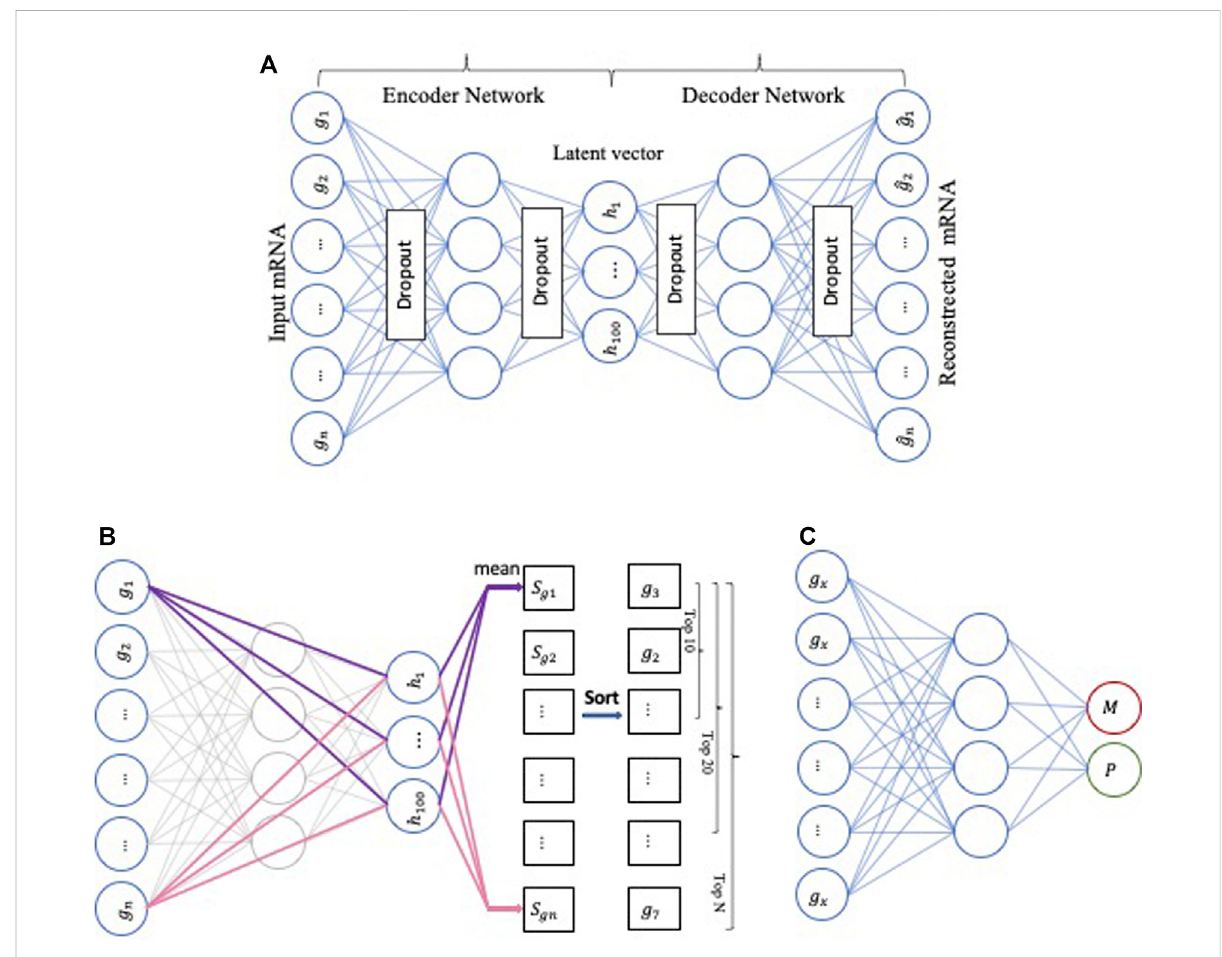
FIGURE 2 The work fl ow represents the fi rst part of our model ’ s framework. (A) The architecture of AutoEncoder, (B) Applying DeepLIFT to compute the importance scores in the Encoder network, (C) Using DNN as a baseline method to perform the metastasis